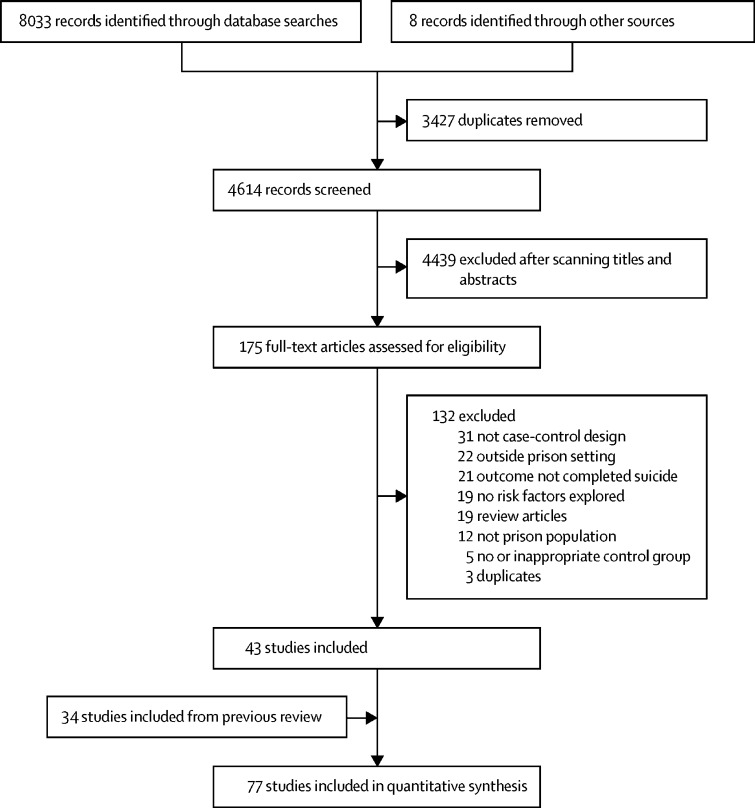
Study selection